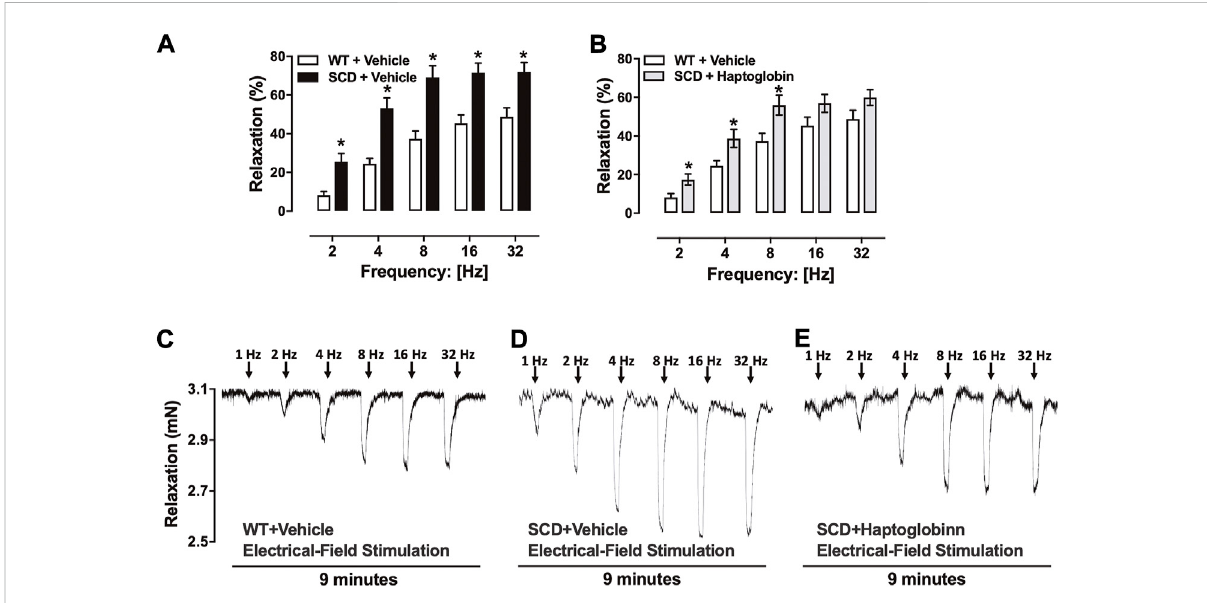
FIGURE 2 Relaxation responses induced by electrical- fi eld stimulation (EFS) in corpus cavernosum strips WT (A) and SCD mice treated (B) or not with haptoglobin (Hap). Data were calculated relative to the maximal changes from the contraction produced by phenylephrine (10 – 5 M) in each tissue, whichwastakenas100%.Datarepresentthemean±SEMfor6miceineachgroup. * p < 0.05vs.WT-Vehicle. # p < 0.05vs.SCD-Hap.Representative tracings of relaxant response to EFS in corpus cavernosum strips from WT (C) and SCD mice treated with vehicle (D) or haptoglobin (E)